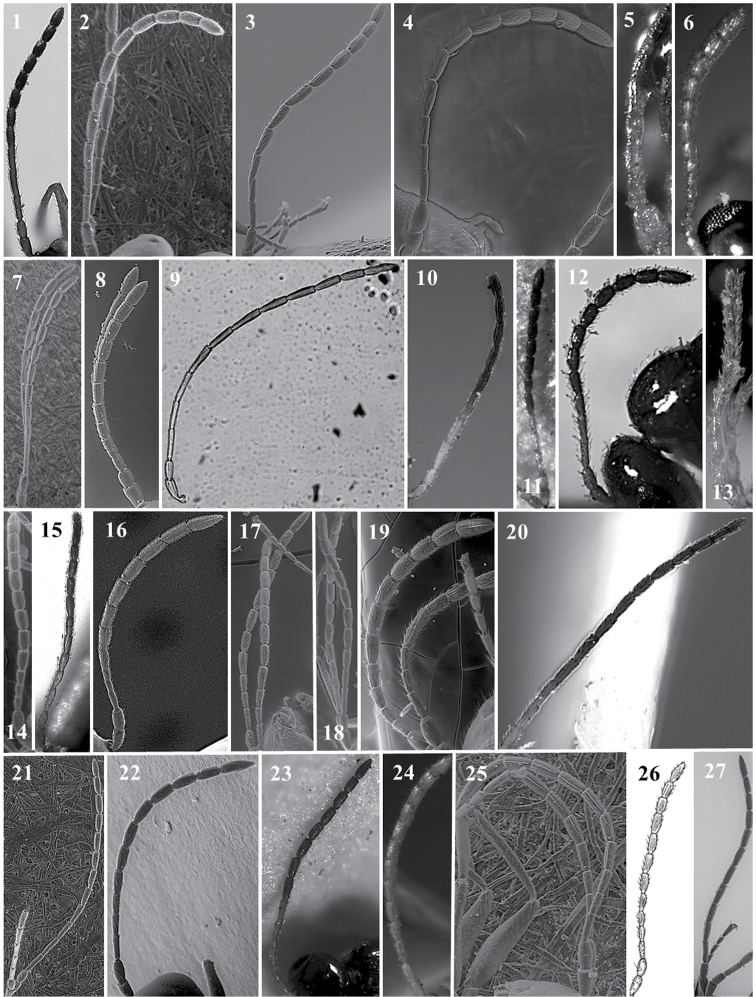
Alloxysta antennae. A.abdera (1); A.andrewsi (2); A.antananarivoi (3); A.antsirananae (4); A.aperta (5); A.apteroidea (6); A.arcuata (7); A.asiatica (8); A.aurata (9); A.australiae (10); A.basimacula (11); A.brachycera (12); A.brachyptera (13); A.brevis (14); A.brevitarsis (15); A.carinata (16); A.castanea (17); A.circumscripta (18); A.citripes (19); A.commensuratus (20); A.costaricensis (21); A.consobrina (22); A.crassa (23); A.crassicornis (24); A.darci (25); A.desantisi (26); A.evenhuisi (27).